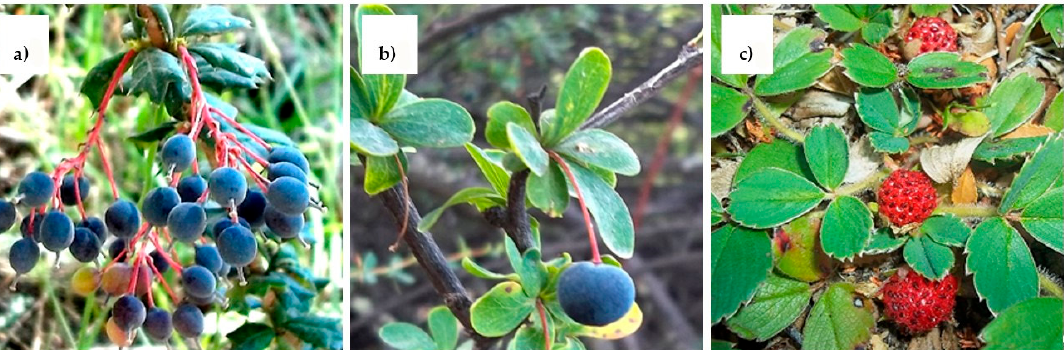
Figure 1. Fruits from Argentinean Patagonia berries: ( a ) Berberis darwinii , ( b ) Berberis microphylla , and ( c ) Fragaria chiloensis